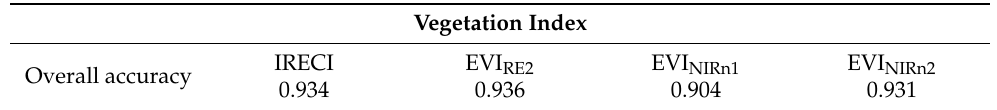
Table 4. Overall accuracy of vegetation indices selected for distinguishing Populus euphratica reference samples.